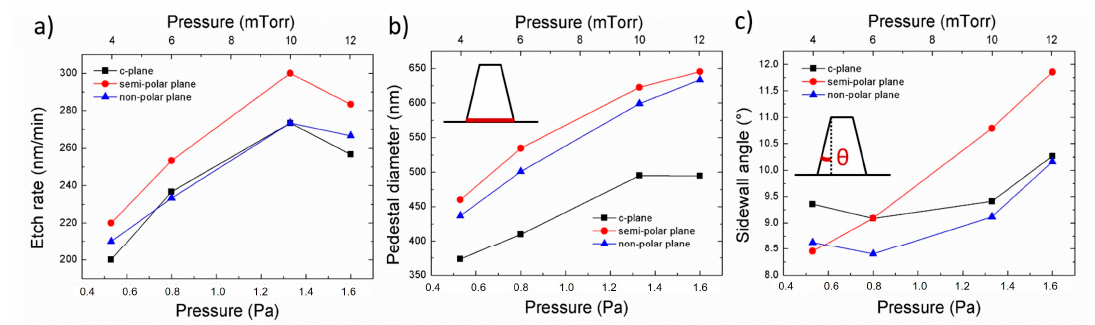
Figure 5. ( a ) Etch rate, ( b ) base diameter and ( c ) sidewall angle of c -plane, (1122) semi-polar and (1120) non-polar GaN layers as a function of the pressure. The pedestal diameter and sidewall angle are schematically described in ( b , c ), respectively.